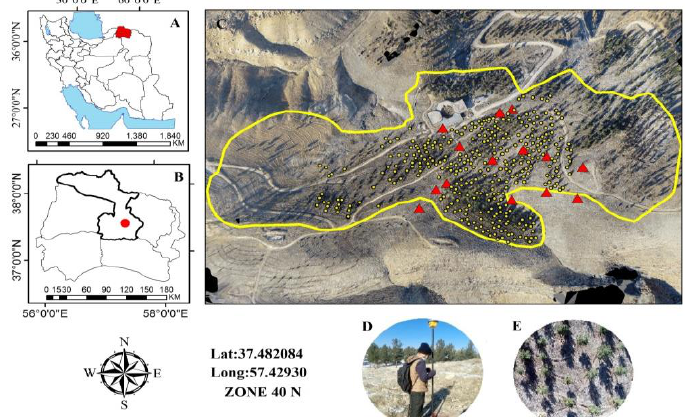
Figure 1 . The study area in Iran (A), North Khorasan Province (B), Pardisan Park, red triangulation: target point, yellow point: 324 pine tree (C), Field target point (D), Orthophoto